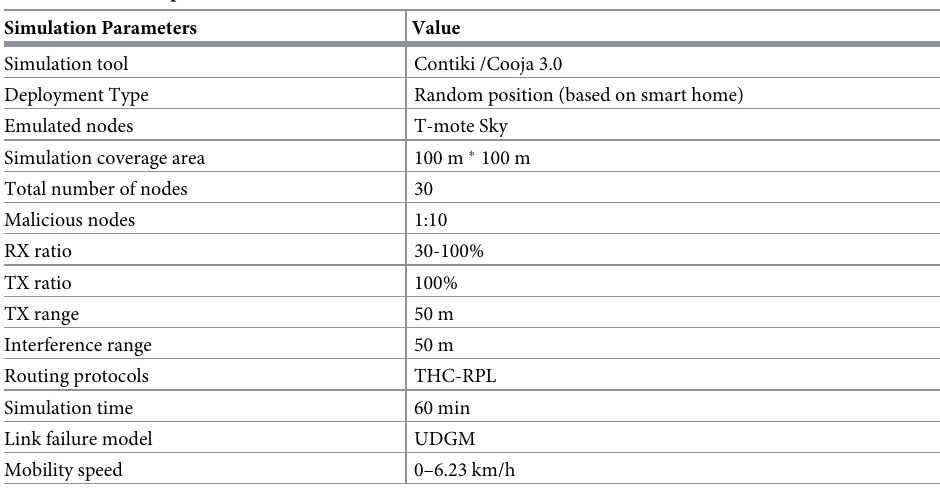
Table 4. Simulation